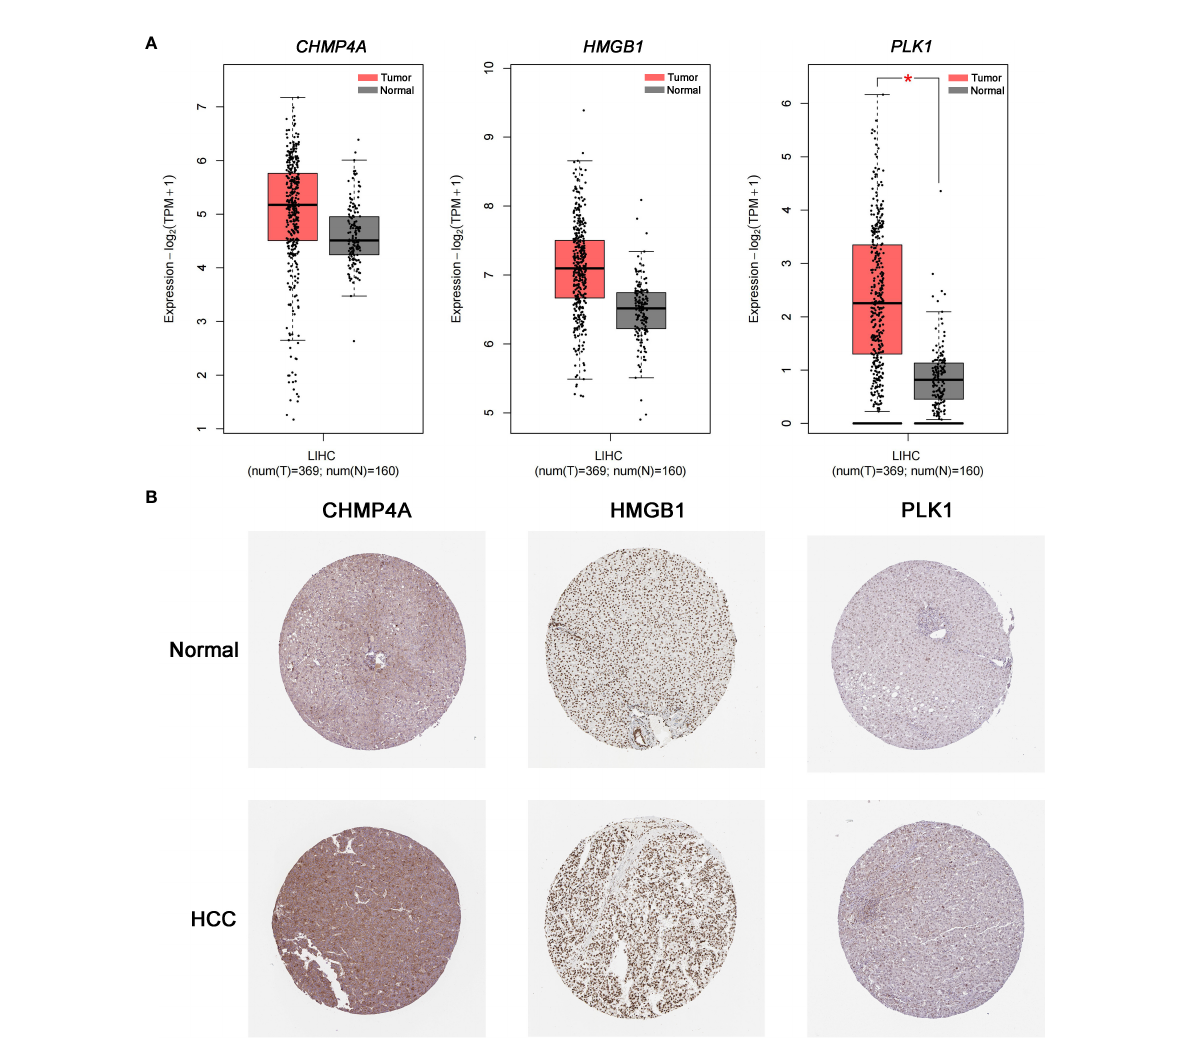
FIGURE 8 Validation of the differential expression of the three prognostic genes in clinical samples. (A) The mRNA levels of CHMP4A , HMGB1 and PLK1 were detected in normal tissues and HCC tissues from the GEPIA * P < 0.05. (B) Immunohistochemistry of the CHMP4A, HMGB1 and PLK1 was determined in HCC tissues and normal tissues from the HPA